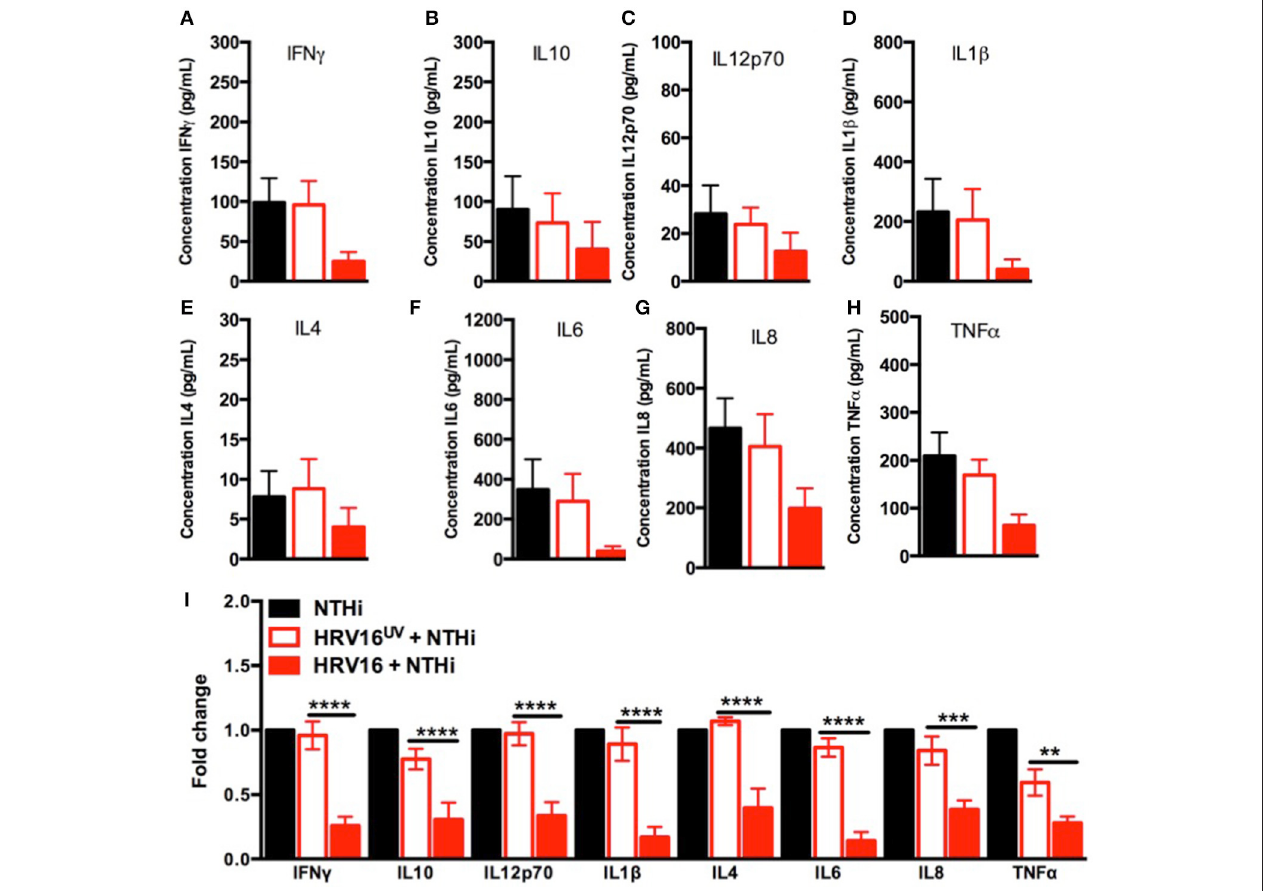
FIGURE 3 | Human macrophages exposed to HRV16 cannot secrete elevated levels of pro-inflammatory and regulatory cytokines in response to NTHi. Human macrophages were exposed to HRV16 (red bars), HRV16 UV (open bars) or MI (black bars) for 1h and rested overnight before being exposed to NTHi for 2h. Supernatants were collected and analyzed by MSD. MSD results for (A) IFN γ , (B) IL10, (C) IL12p70, (D) IL1 β , (E) IL4, (F) IL6, (G) IL8, (H) TNF α . (I) Relative fold changes for cytokine production in HRV16 and HRV16 UV exposed human macrophages vs NTHi. ** p < 0.01, *** p < 0.001, **** p < 0.0001 Two Way Anova with Dunnett’s Post Test vs. HRV16 UV . Error bars represent standard error of the mean (SEM). n = 5 independent experiments on different donors.